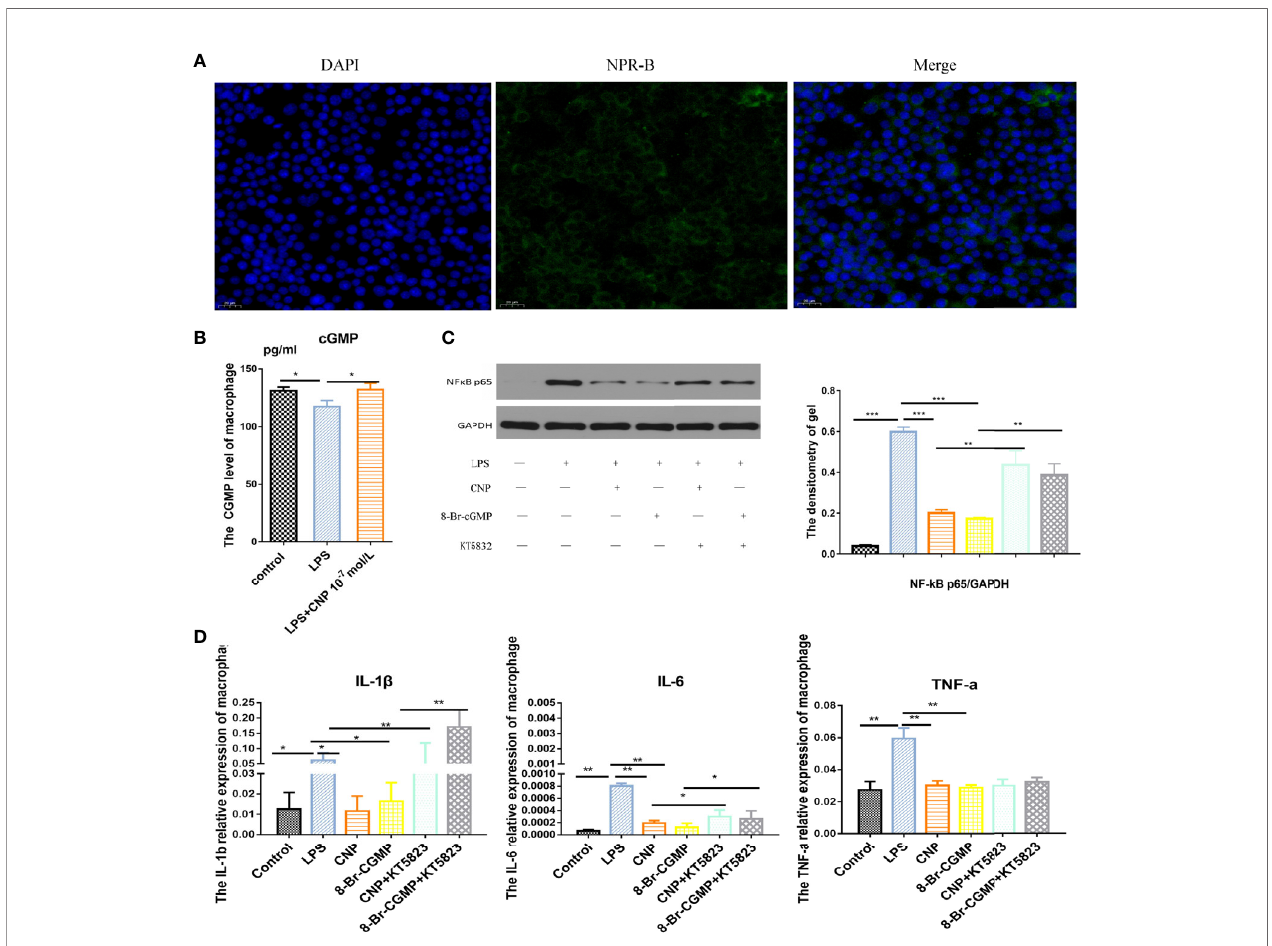
FIGURE 5 | CNP represses NF-kB to release pro-in fl ammatory factors by the cGMP/PKG signaling pathway in macrophages. (A) Immuno fl uorescence showed the location of NPR-B in RAW264.7macrophages. (B) ELISA revealed intracellular cGMP level in macrophages cultured with CNP for 6 h. (C) Western blot analysis showed NF-kB protein expression after incubation with CNP, 8-Br-cGMP or KT5823 alone or in combination and was quanti fi ed in images. (D) qPCR showed the mRNA levels of the downstream pro-in fl ammatory cytokines IL-6 , TNF- a , and IL-1 b . The data shown are representative of multiple experiments (mean ± SD, n = 3, *P < 0.05, **P < 0.01, ***P <